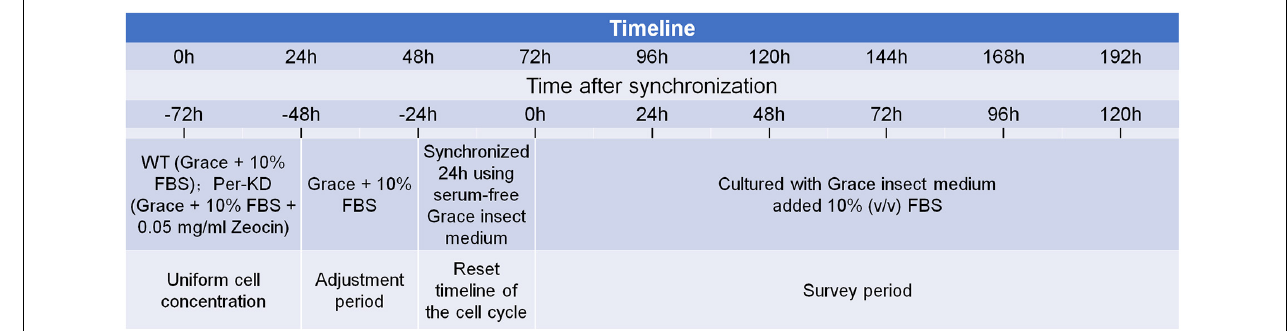
FIGURE 1 | Study timeline and cell pretreatment.